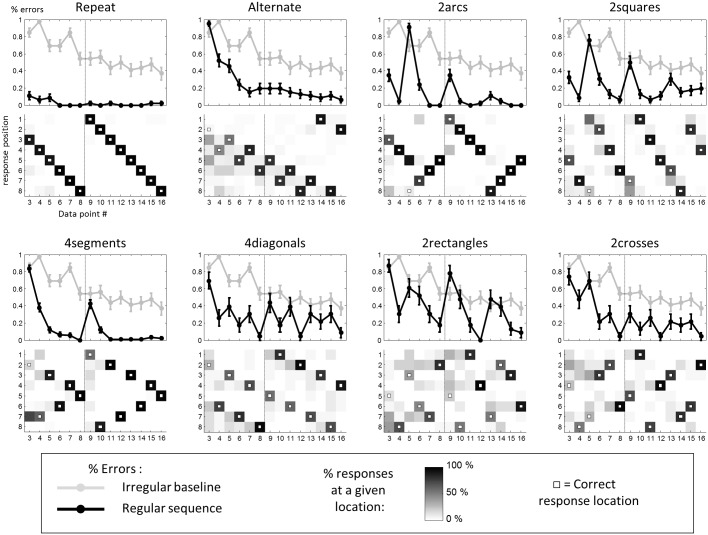
Performance of adult participants in experiment 1.Top panels show the evolution of error rate across successive steps (data points 3–16 in adults) for each regular sequence (error bars = 1 SEM). The gray curve in the background shows the error rate for irregular sequences, which serve as a baseline. Bottom panels show the percentage of responses at a given location for each data point. White dots indicate the correct location. Vertical dashed lines mark the transition between the two 8-item subsequences that constitute the full 16-item sequences.